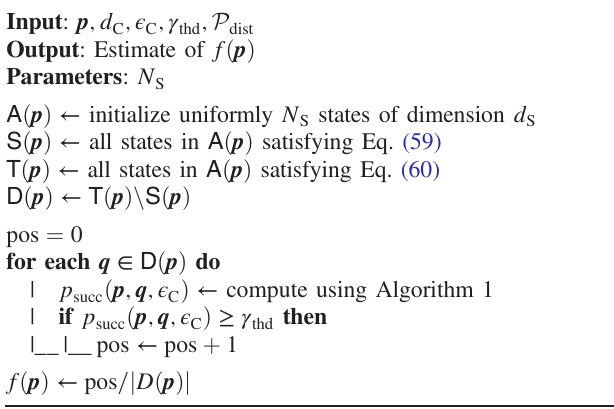
Algorithm 2. Estimating f ð p Þ by